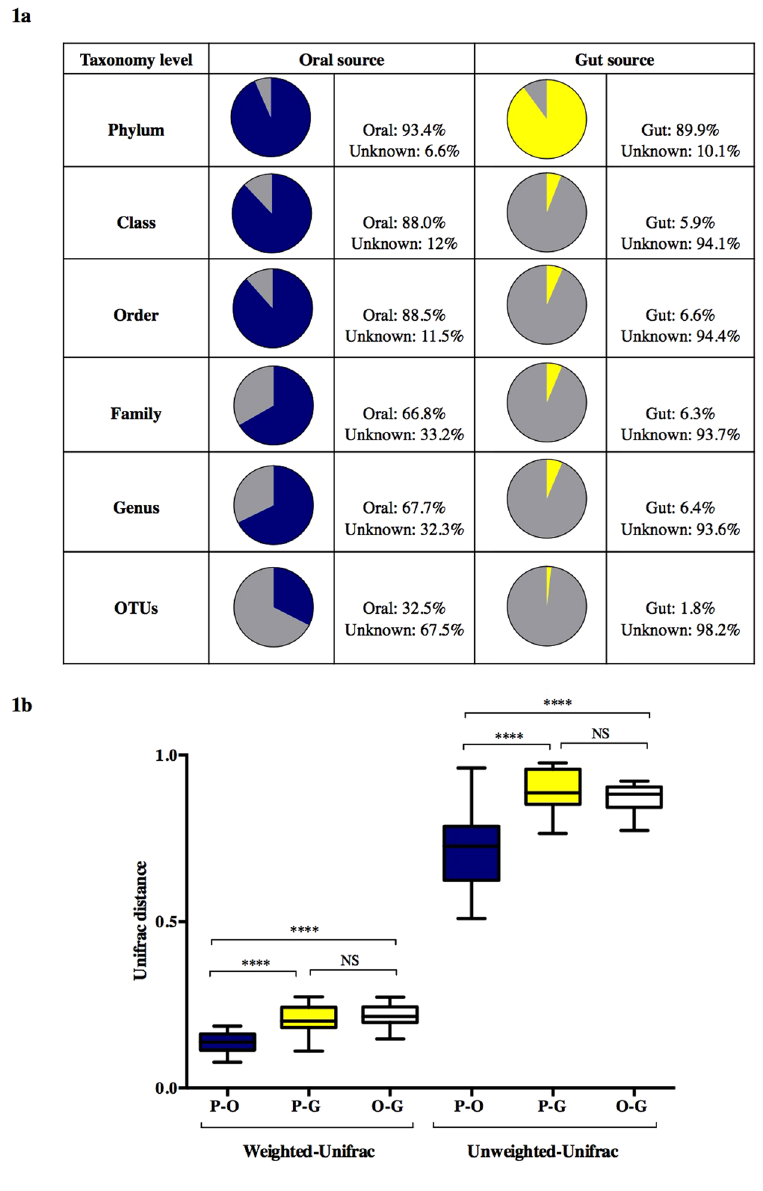
Figure 1. Maternal oral and gut microbial influences on the placental microbiome ( a ). Bayesian source- tracking results for placental samples at different taxonomic levels. Proportions of the maternal oral (blue), gut (yellow) and unknown source of environment (grey) on the placental microbiome. Placental samples showed a greater degree of similarity with the maternal oral microbiome. ( b ) Boxplots showing distances from unweighted and weighted Unifrac distances between the maternal oral (blue) and gut (yellow) with respect to the placental microbiome and between the oral and gut (white) microbiomes (permutations = 999). Each boxplot shows the median, lower and upper quartiles of the Unifrac distances. A lower Unifrac distance shows a greater resemblance between the two microbial communities. Pair-wise comparison were done by Mann- Whitney U tests and annotated as **** p < 0.0001 and NS: not